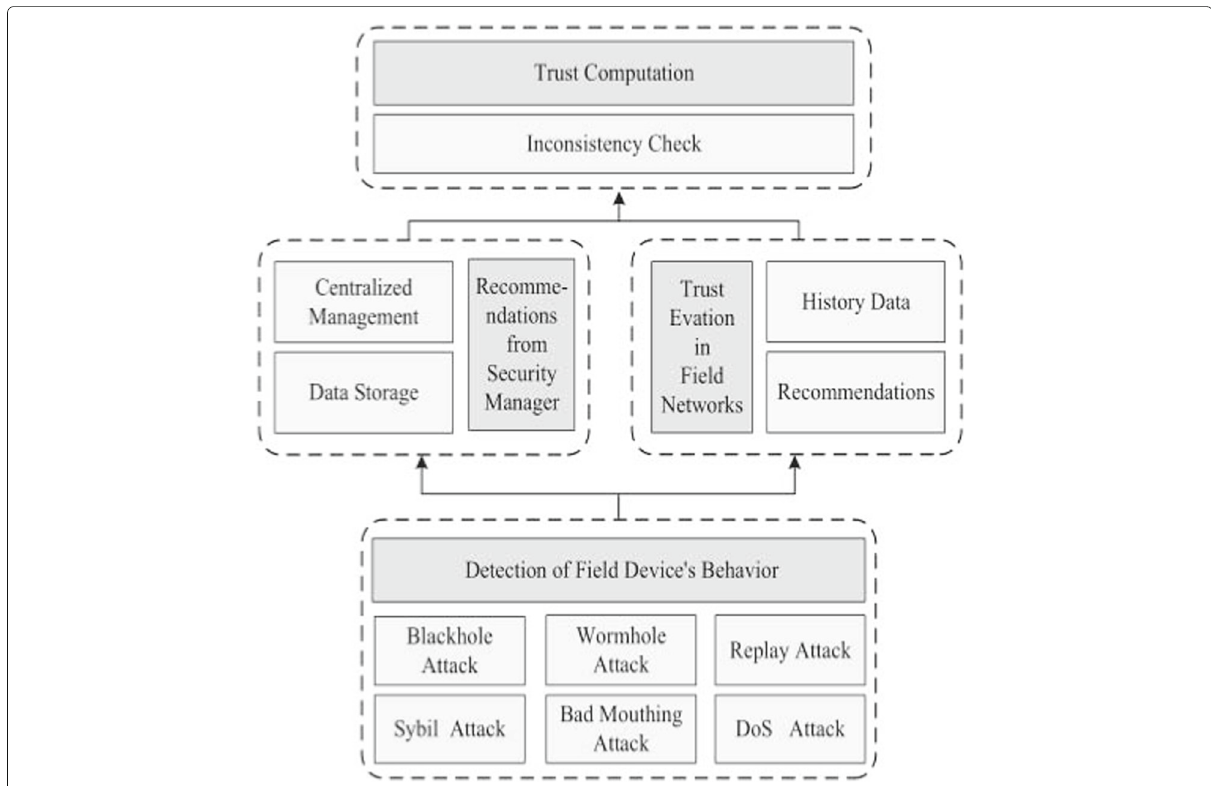
Fig. 3 A typical trust scheme architecture